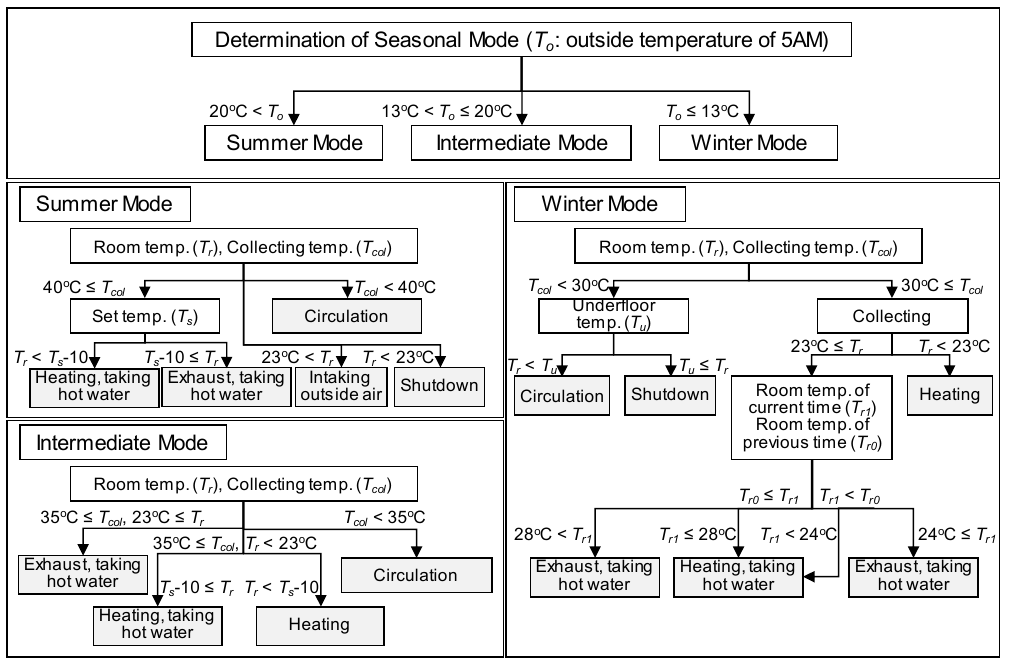
Figure 9. Operation control of air-based solar heat collection